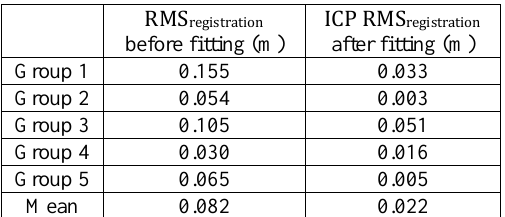
Table 3 Estimated transformation parameters of point to plane